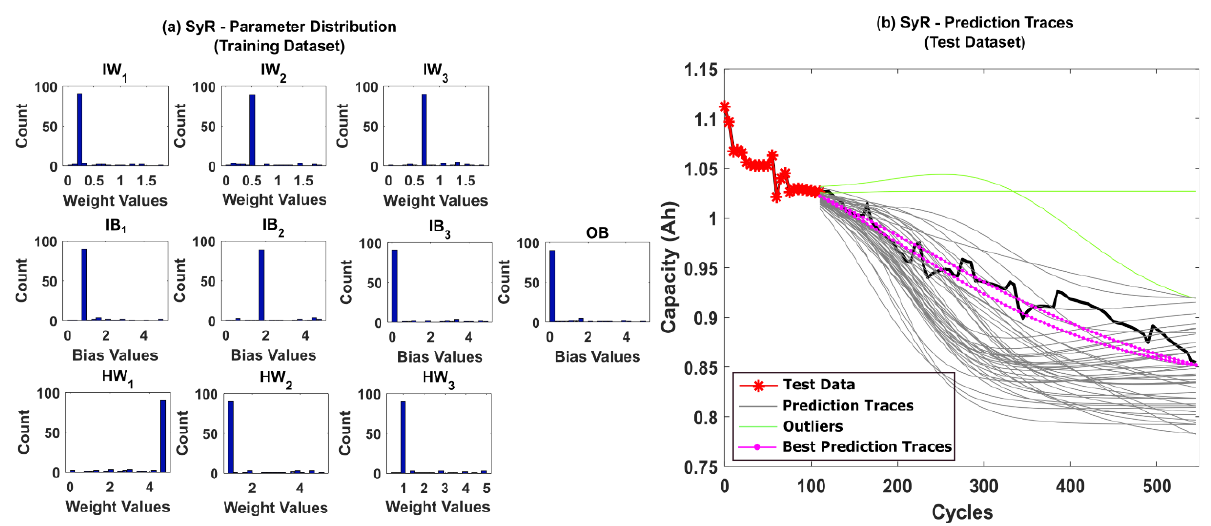
Figure 8. ( a ) The posterior distribution of MLP network parameters estimated by the adaptive Bayesian learning framework using SyR and ( b ) the degradation prediction traces for CALCE battery (CS-37) using SyR. The prediction traces for 50 repetitions are shown using the gray lines, the green lines represent outliers, and the magenta lines represent the traces with minimum RMSE values.